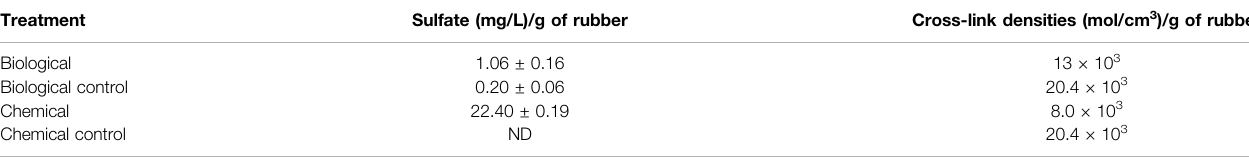
TABLE 1 | Quanti fi cation of sulfate ion and determination of cross-link densities after biological and chemical treatments for Gram of rubber. For the biological negative control, the cultivation medium did not include rubber particles. For the chemical negative control, rubber particleswere suspended in 1% HNO 3 without the microwave treatment. ND: not detected. Statistical analysis showed signi fi cant differences between all the different treatments. Standard error is showed for sulfate quanti fi